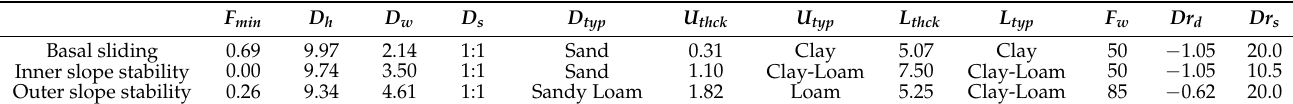
Table 3. Minimum F ( X ) per failure mechanism and parameter values of input vector X resulting in that minimum F ( X ) . See Table 1 for the abbreviations and units of the parameters.